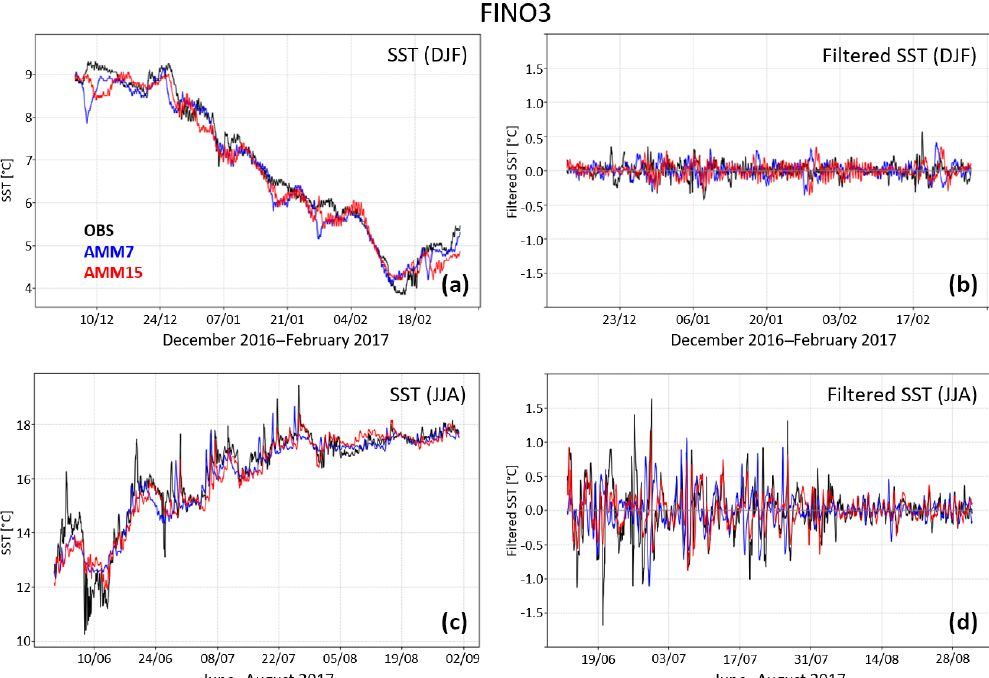
Figure 10. Time series of sea surface temperature (a, c) and filtered SST (b, d) for the FINO 3 buoy for December 2016–February 2017 (a, b) and June–August 2017 (c, d) . Observations are shown in black, AMM7 in blue, and AMM15 in red.